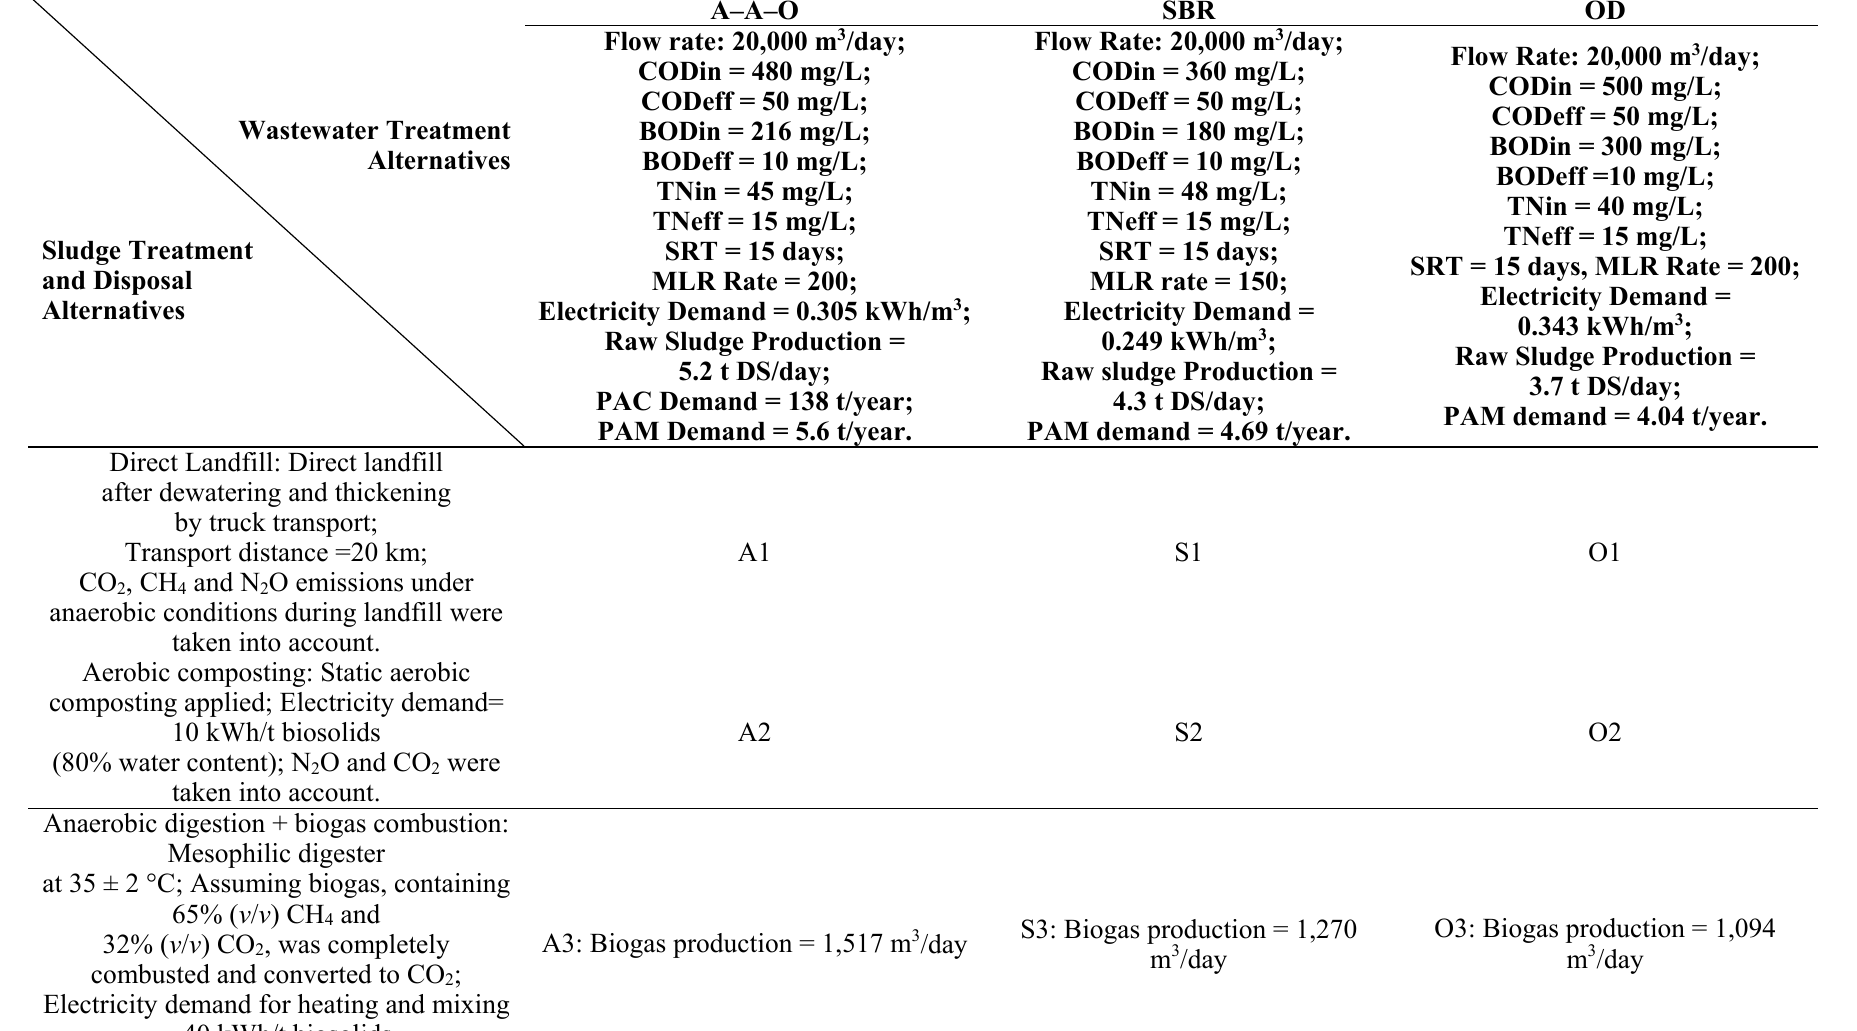
Table 1. Operating parameters and inventory data for the twelve wastewater and sludge treatment scenarios of this